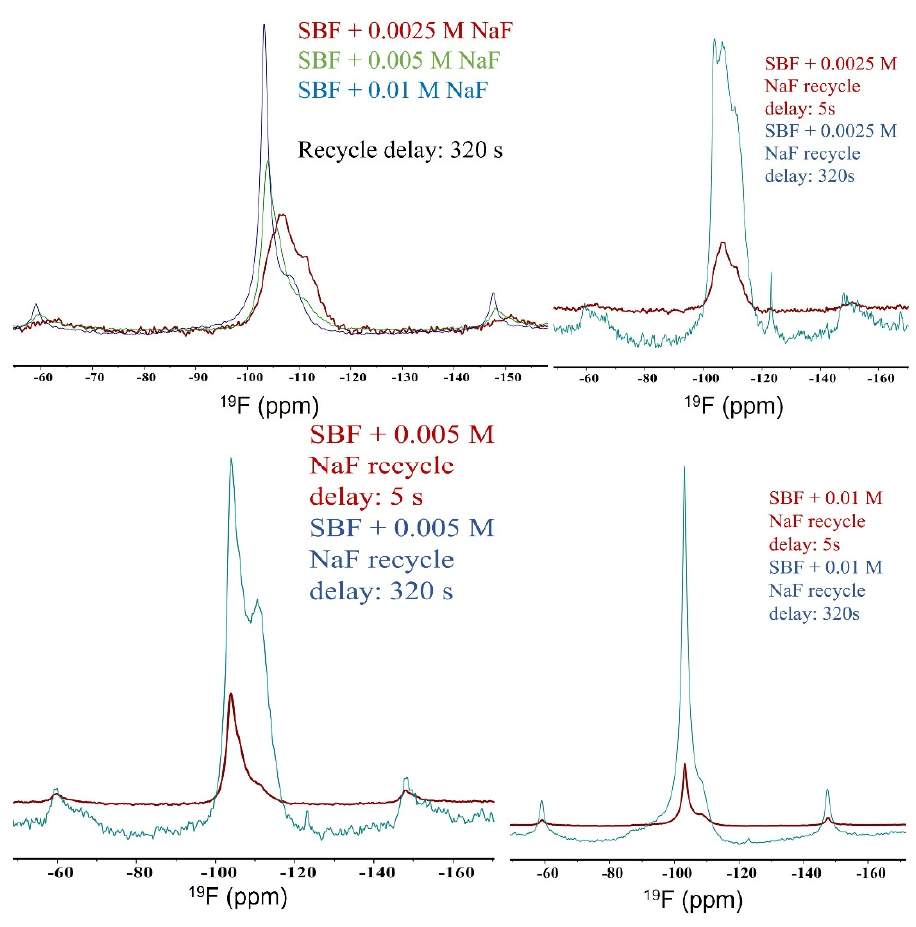
Figure 4. 19 F 35 kHz MAS spectra of HAp synthesized in SBF and soaked in solutions at different NaF concentrations (2.5 mM, 5 mM, and 10 mM) for different recycle delays (brown: 5 s; green: 320 s).